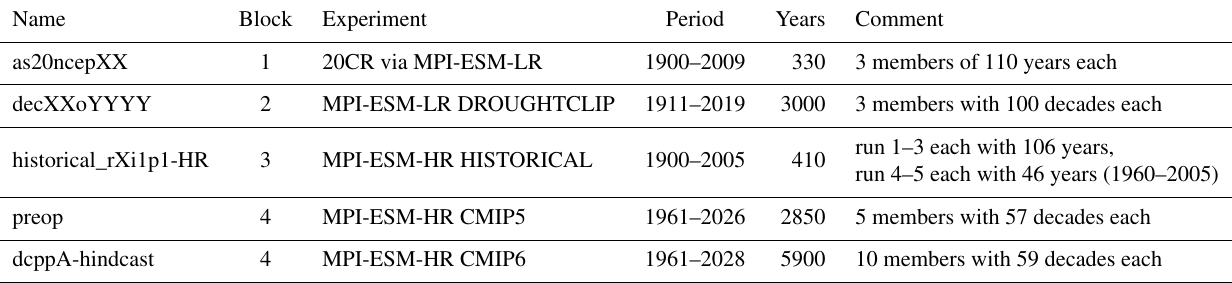
Table 1. Overview of the RCM ensemble LAERTES-EU with the name of the simulation within the MiKlip project, the classification into data blocks, the underlaying setup (experiment), the covered time period, and the number of simulation years; XX stands for the ensemble number and YYYY stands for the initialization